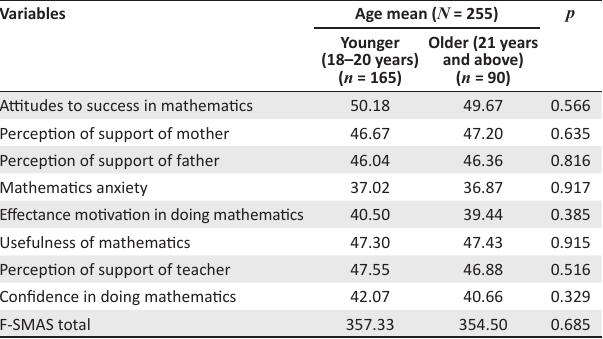
TABLE 3: Differences in the attitudes of black students and Indian students towards mathematics. Variables